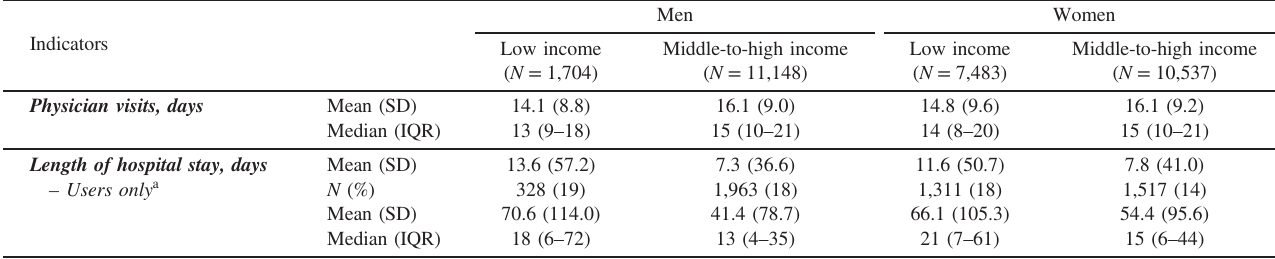
Table 2. Annual medical services utilization by gender and household income category Indicators